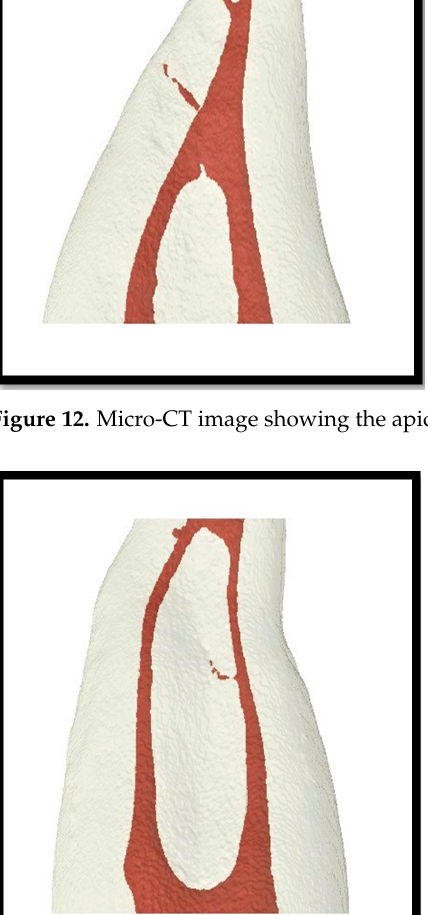
Figure 14. Micro-CT image showing the middle third location of the isthmus. Figure 15. Micro-CT image showing the coronal third location of the isthmus. 4. Discussion The results of our study revealed many canal types in conformity with Vertucci’s classification, while some additional canal types were also detected. Thorough awareness